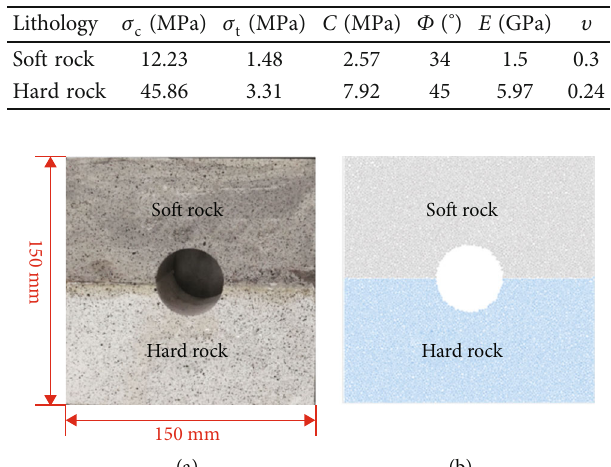
Table 1: Physical and mechanical parameters of soft rock and hard rock.